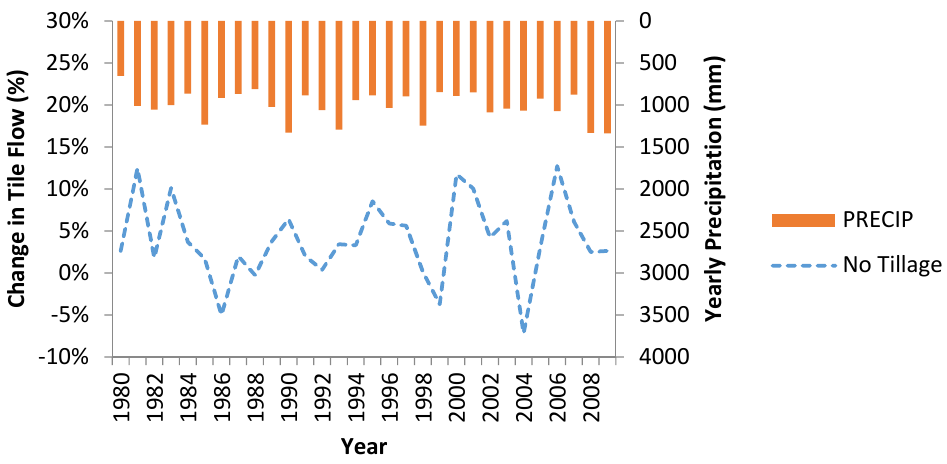
Figure 5. Change in tile flow for no tillage practice compared with conventional tillage.